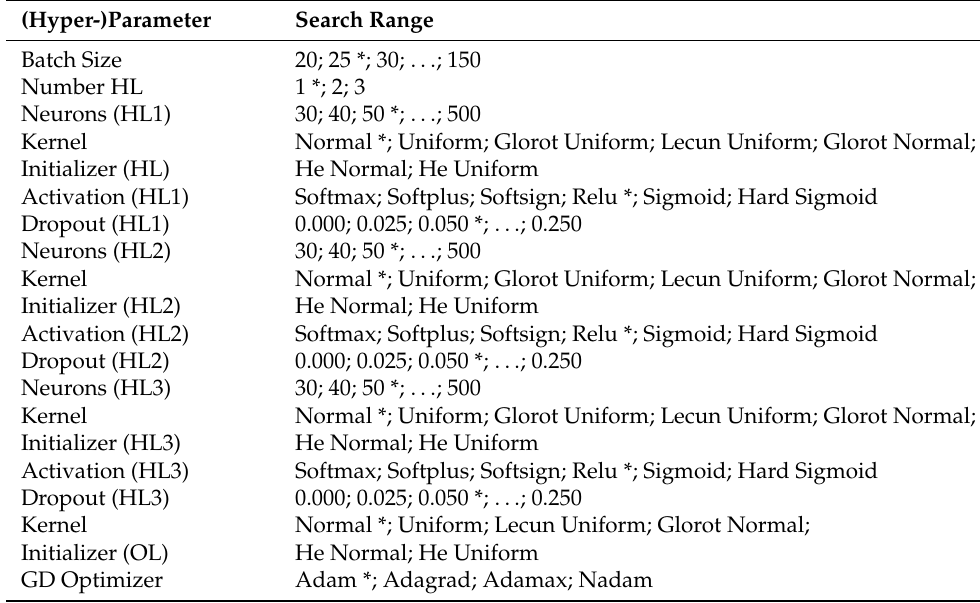
Table A5. Hyperparameter optimization search range (* = default parameter).